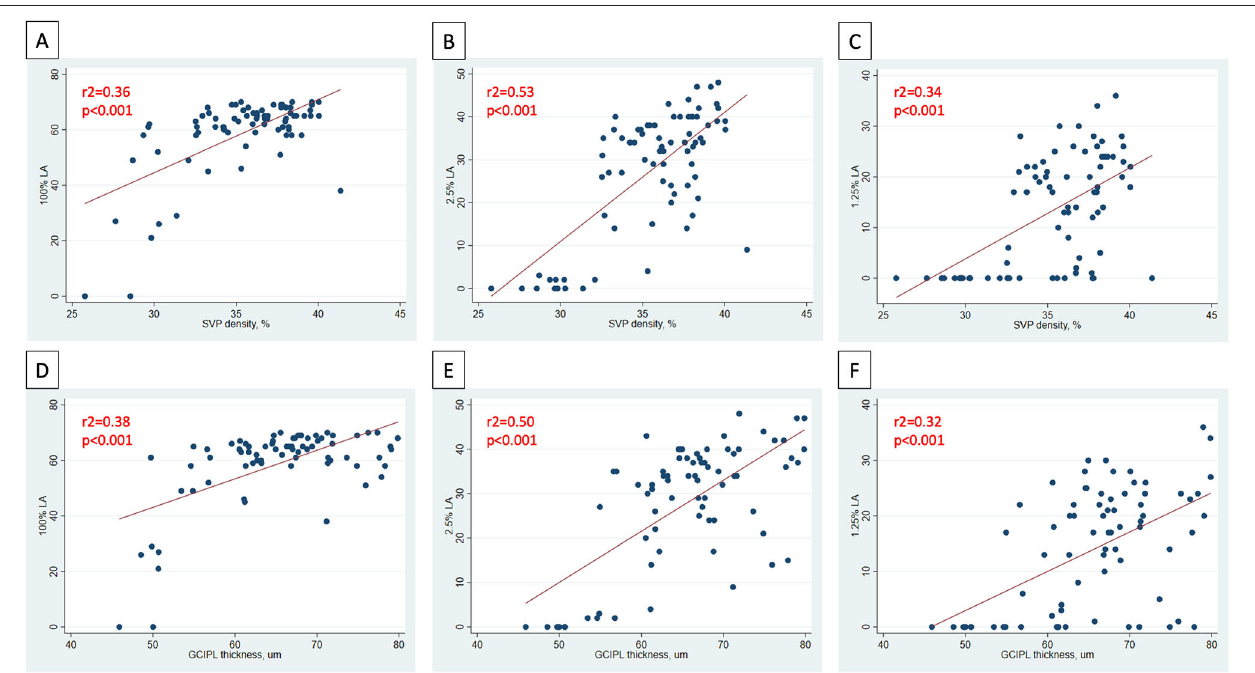
FIGURE 5 | Relationships between OCT/OCTA and visual function measures in individual MS ON eyes. In MS ON eyes at least 3 months post-ON (after resolution of the acute phase of ON), relationships between SVP density and 100% contrast LA, 2.5% contrast LA, and 1.25% contrast LA in the MS ON eye are demonstrated in (A–C) . In MS ON eyes at least 3 months post-ON, relationships between GCIPL thickness and 100% contrast LA, 2.5% contrast LA, and 1.25% contrast LA in the MS ON eye are demonstrated in (D–F) . P -values were calculated using mixed-effects linear regression accounting for intra-subject correlations. R 2 -values were estimated from the mixed-effects model using the Snijders and Bosker